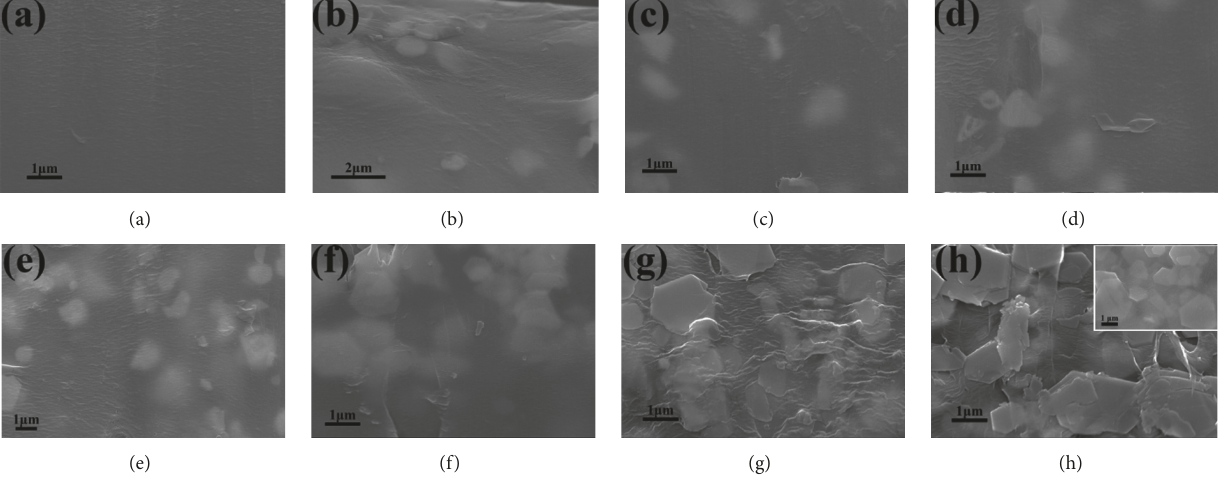
Figure 4: Cross-sectional SEM images of the Bi 2 Se 3 /PVDF nanocomposite films with Bi 2 Se 3 volume fractions of (a) 0 vol.%, (b) 2 vol.%, (c) 4 vol.%, (d) 6 vol.%, (e) 8 vol.%, (f) 10 vol.%, (g) 15 vol.%, and (h) 20 vol.%.